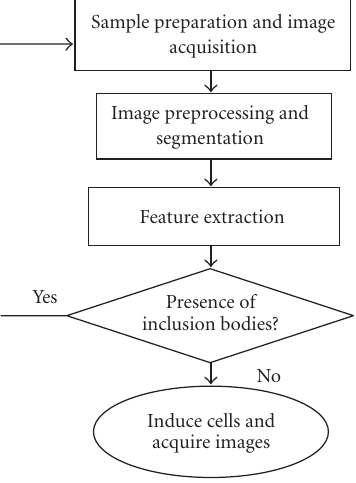
Figure 2: Basic methodology for sample handling and image acqui- sition.